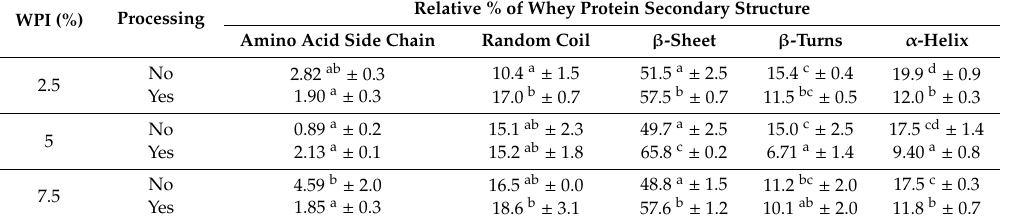
Table 3. FTIR Analysis of the secondary structure of whey protein in CE samples before and after the HOC